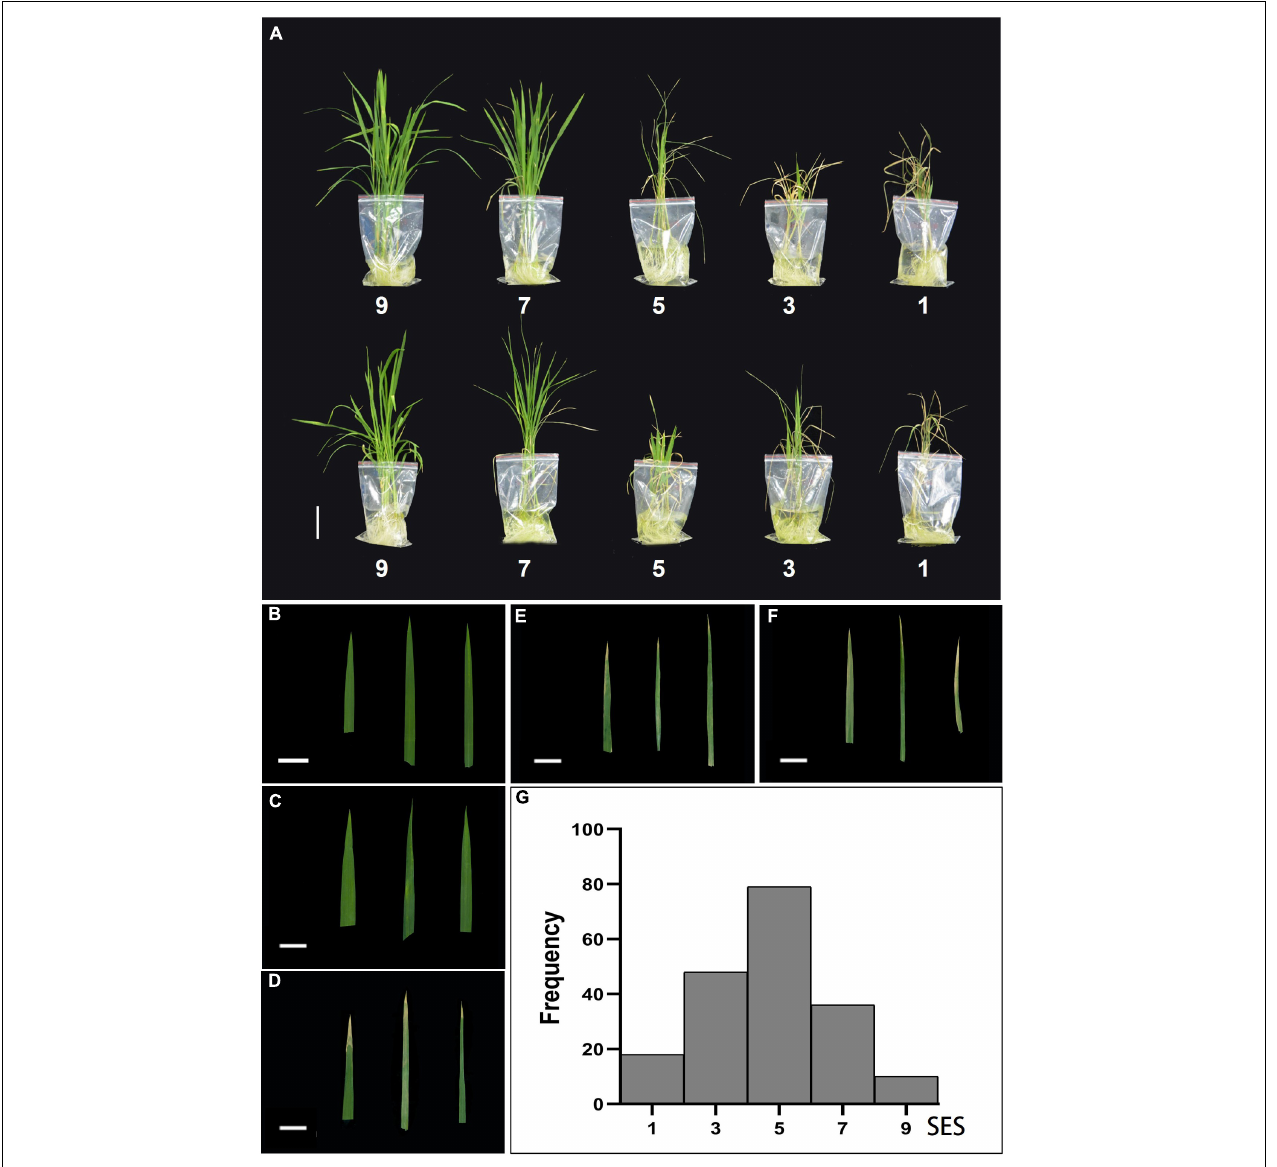
FIGURE 2 | Classification and frequency histogram of the salt tolerance evolution score (SES) in the entire population. (A) Morphological responses of ten different rice varieties under 100 mM NaCl stress based on the salt tolerance evolution score (SES). Scale bar: 5 cm. Phenotypic characterization of five SES [9 (B) , 7 (C) , 5 (D) , 3 (E) , 1 (F) ] of the visual symptoms in leaves. Scale bar: 2 cm. (G) Frequency histogram of the SES in the entire population.